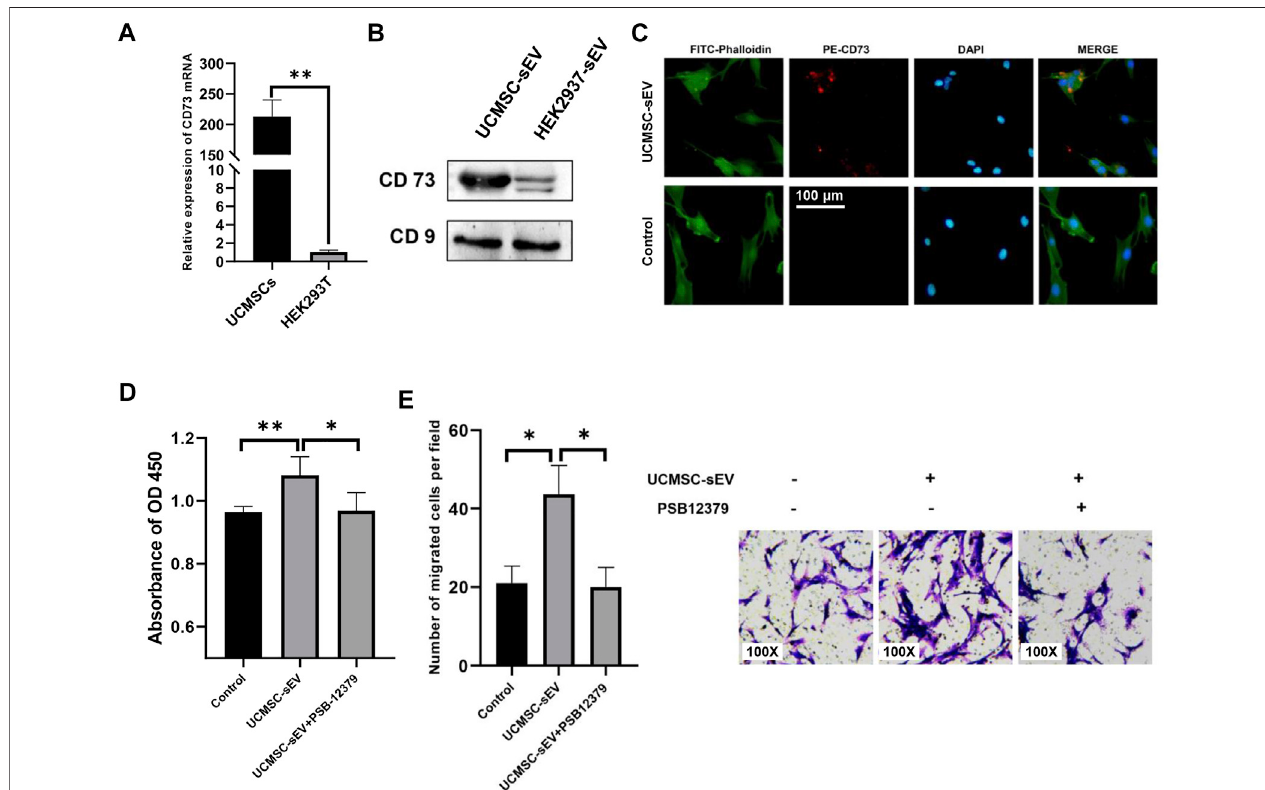
FIGURE 3 | UCMSC-sEV promote proliferation and migration through CD73 molecules. (A) Detection of the mRNA expression level of CD73 in UCMSCs using real-time PCR (HEK293T was used as the control group). (B) Western blotting was used to detect the protein expression level of CD73 in UCMSC-sEV (HEK293T-sEV were used as the control group). (C) Immuno fl uorescence staining shows that PE-CD73-labeled sEV are internalized by PUMSCs. (D) CCK-8 and Transwell assay results (E) show that the inhibition of the sEV CD73 molecular activity by PSB12379 blocks the proliferation- and migration-promoting effects of